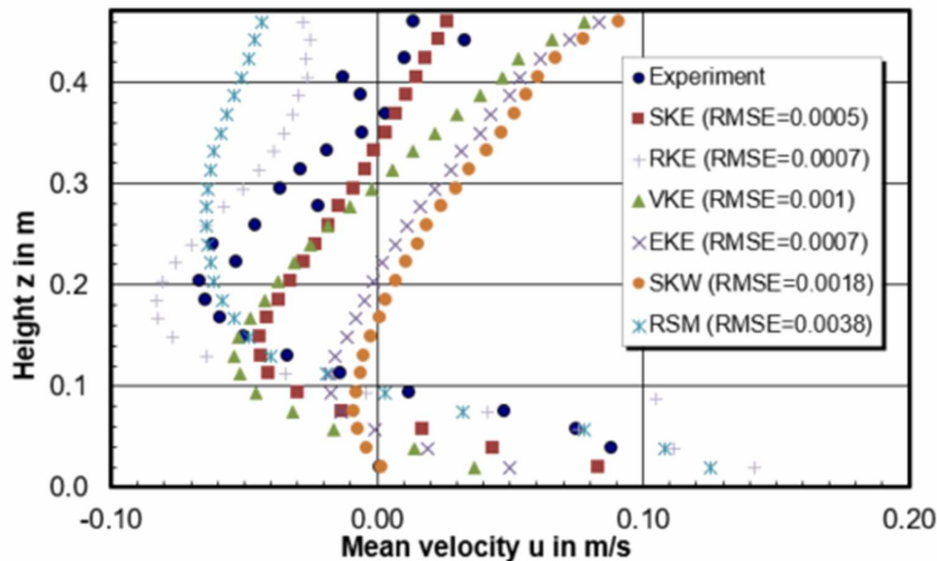
Figure 9. Comparison of horizontal u velocity in a vertical section through the center of the circulation region and root mean squared error (RMSE) between CFD modelling and experiment (mesh size: 0.006 m).